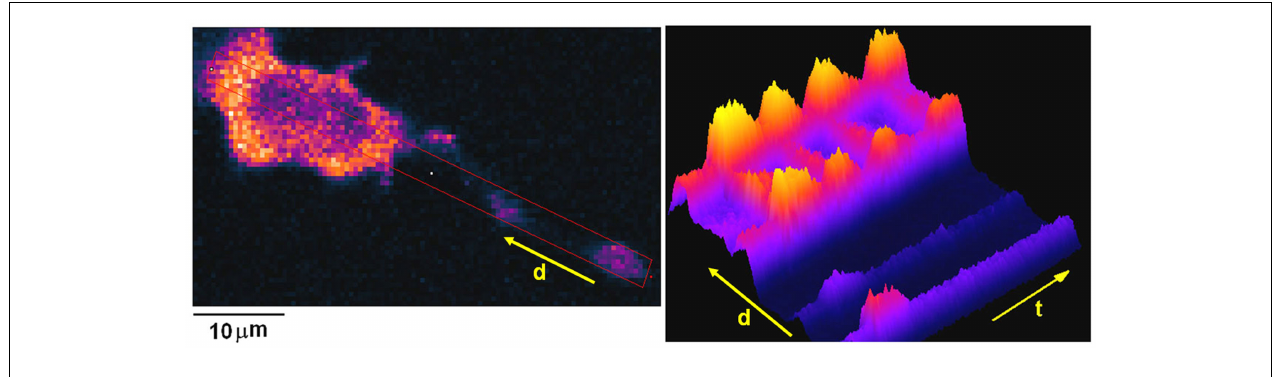
stimulation by antigen in right panel.Warmer colors correspond to larger increases in intracellular [Ca 2 + ]. Right panel:Time vs distance plot of [Ca 2 + ] shows initial response from protrusion (lower left), followed by a series of global Ca 2 + oscillations over the course of several hundred seconds.